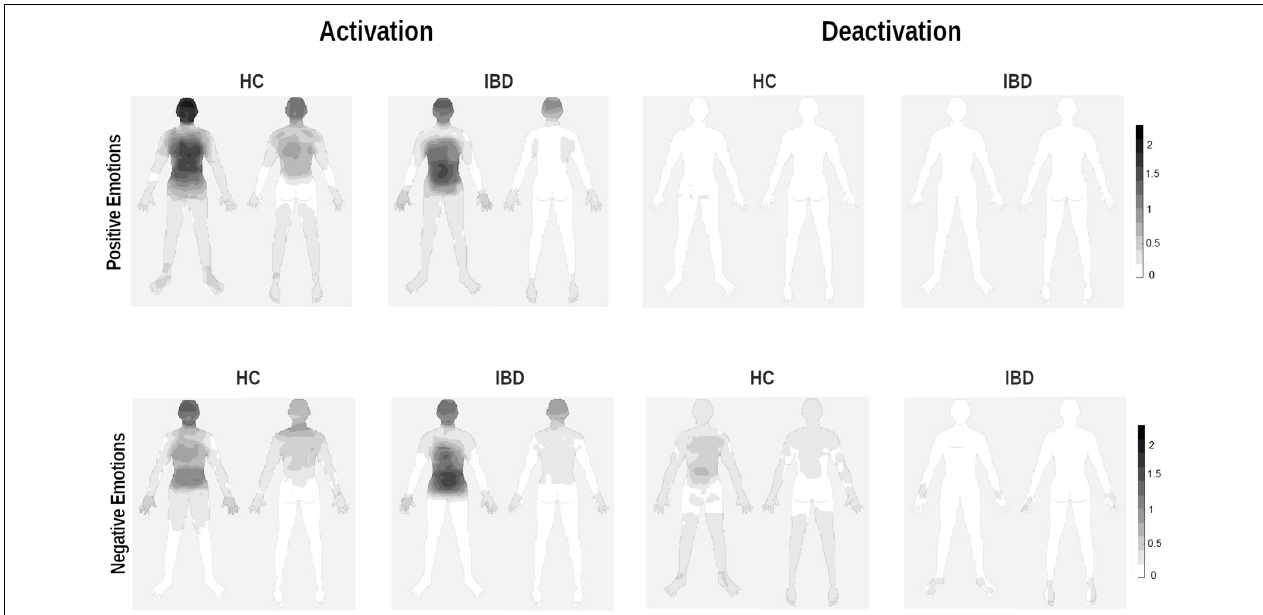
FIGURE 2 | Whole-body topographies visualizing the perceived activation and deactivation for the experience of positive and negative emotions in HC participants and IBD patients (0 = “no activation/deactivation”; 4 = “very strong